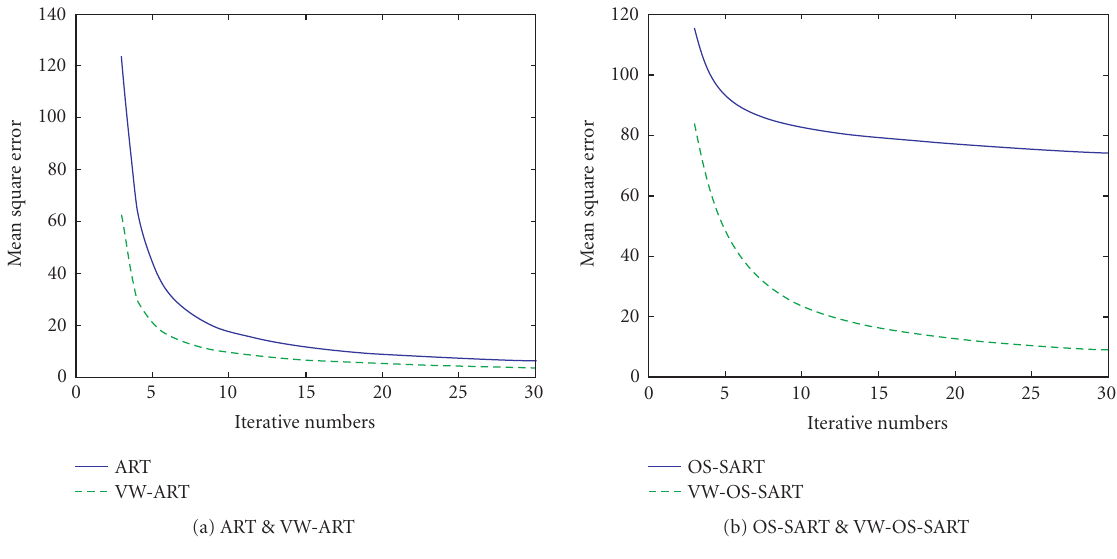
Figure 3: Plot of mean square error as a function of iterative number in the Shepp-Logan phantom experiments.